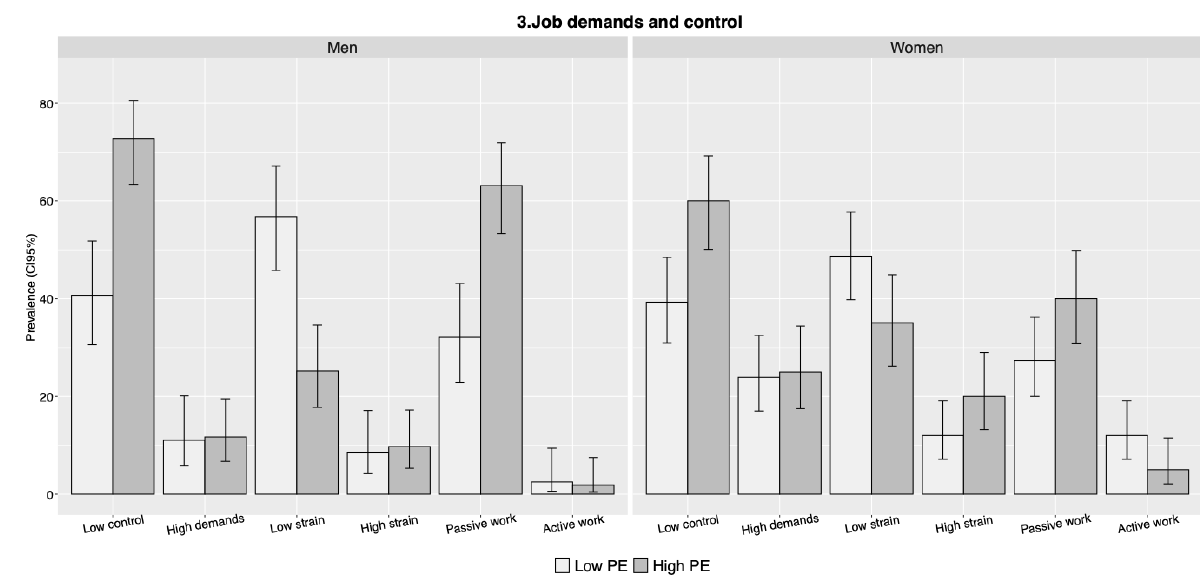
Figure 2. Prevalence of workplace violence, sexual harassment, and discrimination, according to gender and level of PE. ( n = 401).